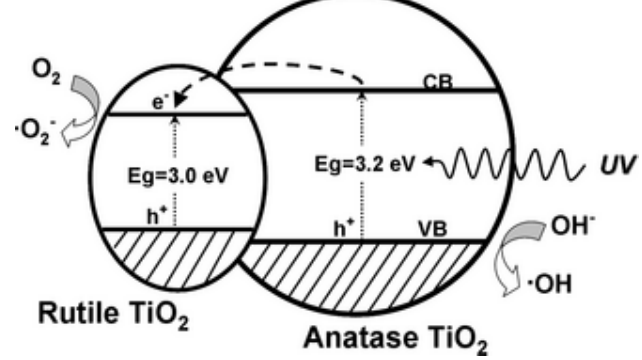
Figure 11. Proposed schematic illustration of the band structure related to photocatalytic mechanism of un-sensitized mixed-phase TiO from [78]. Copyright 2011